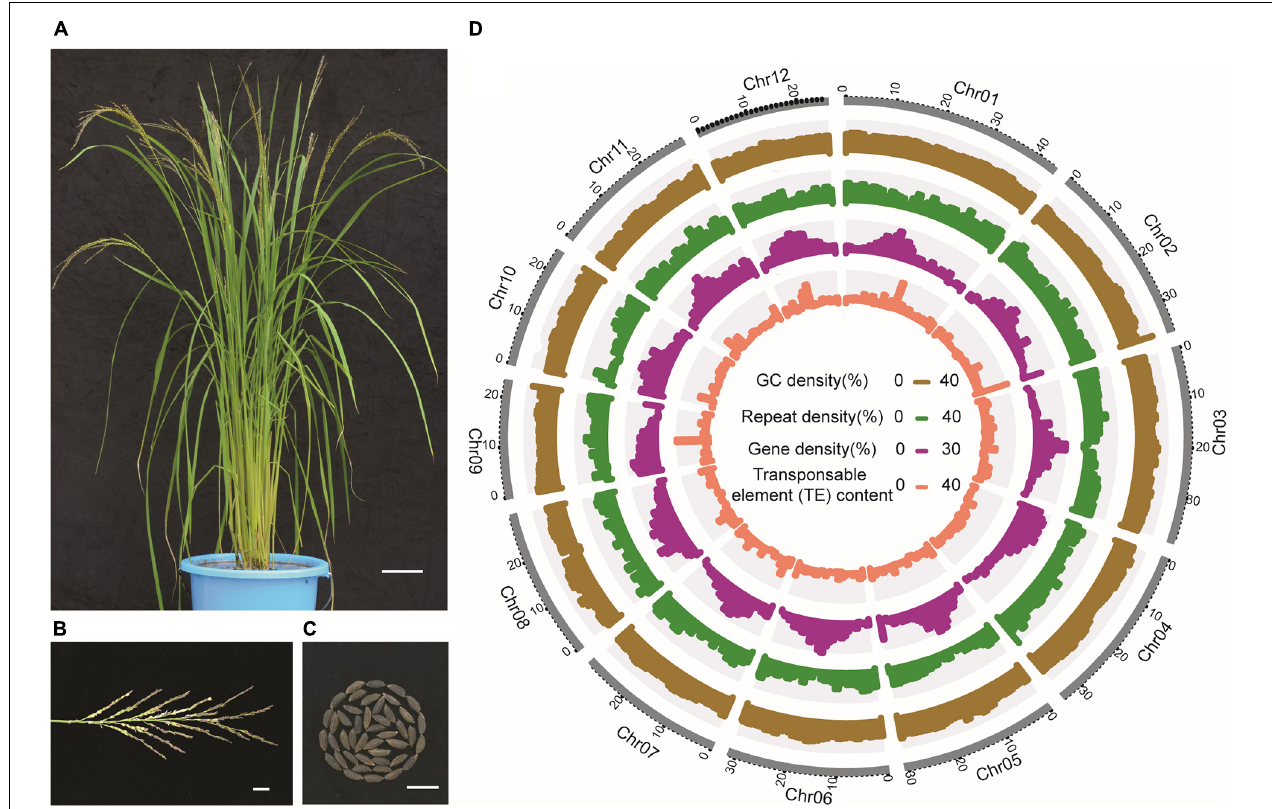
FIGURE 4 | The morphology and genome features of LM8. (A) Whole plants, bar = 10 cm. (B) Panicles, bar = 2 cm. (C) Grains, bar = 1 cm. (D) Genome features of LM8. Circles from inside to outside are transposable element (TE) content, repeat density, gene density, and GC density.